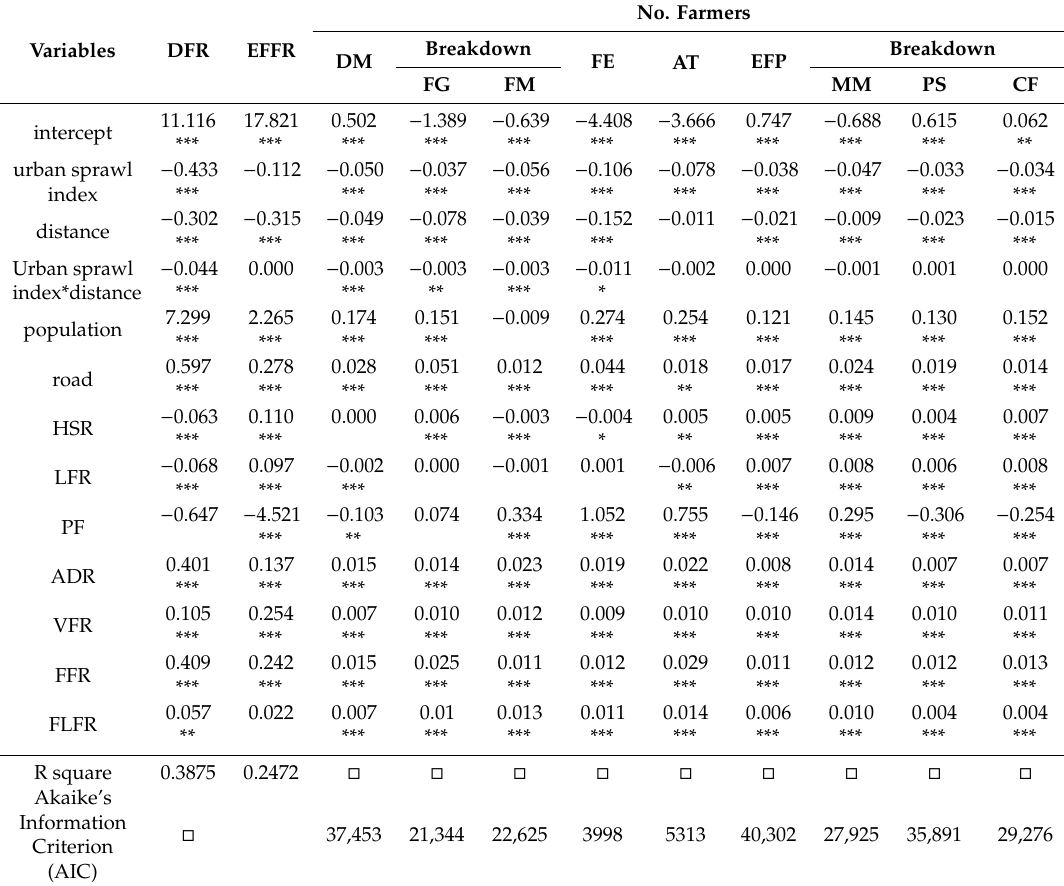
Table 6. E ff ects of urban sprawl and distance from DID on urban agricultural activities in the Tokyo metro